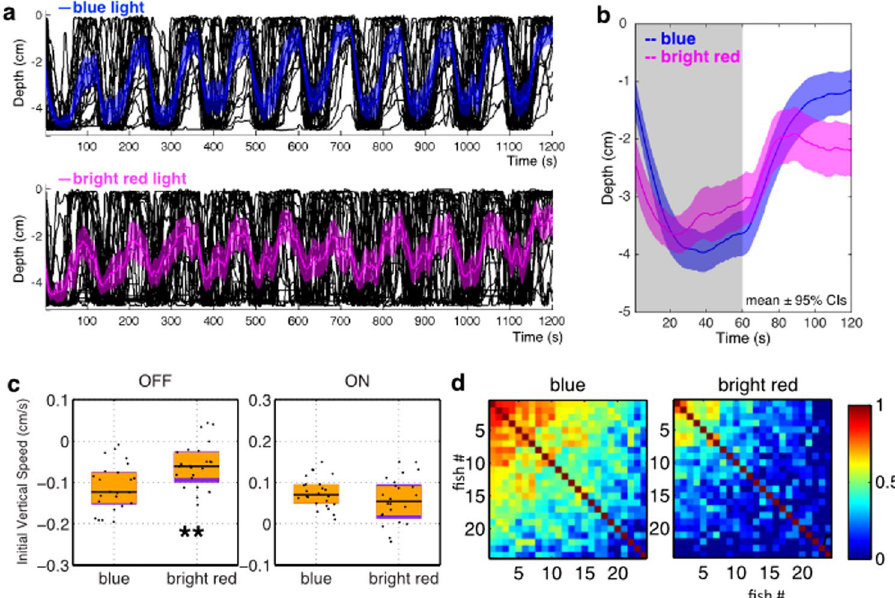
Figure 4. Blue and red light have different effects on vertical migration. ( a ) Vertical migration of fish under blue light and red light of ten-fold higher intensity: ~1.56 × 10 15 cm − 2 s − 1 for blue light, and ~1.6 × 10 16 cm − 2 s − 1 for red light. Black lines represent individual fish, and colored traces represent the average. Shadows indicate 95% CIs. Blue, 470 nm, 650 µ W/cm 2 ; red, 660 nm, 4650 µ W/cm 2 . N = 24 for each group. ( b ) Averaged vertical migration from 10 dark-light cycles, averaged from panel. ( a ) Represented as mean ± 95% CIs. The curve under red light of high intensity is different from the one under blue towards the end of the light ON period. ( c ) Initial 20 s vertical swimming speed. Initial diving speeds upon light offset are different (Mann-Whitney U = 145, ** p = 0.004, two tailed, rank-biserial correlation = 0.50). Initial climbing speeds upon light onset are similar (Mann-Whitney U = 231, p = 0.24, two tailed, rank-biserial correlation = 0.20). Horizontal black lines indicate median values, black dots show speed of individual fish, purple blocks show the 25th and 75th percentiles and orange blocks show 95% CIs. ( d ) Correlation coefficient of vertical position across time during 10 dark-light cycles. Correlation matrices are significantly different ( χ 2 = 12975, df = 276, p < 0.0001. Jennrich’s χ 2 test). Correlation coefficients are lower under red light of high intensity compared to blue light (median r = 0.45 for blue, 0.15 for red; U = 2803, *** p < 0.0001, one tailed Mann-Whitney U